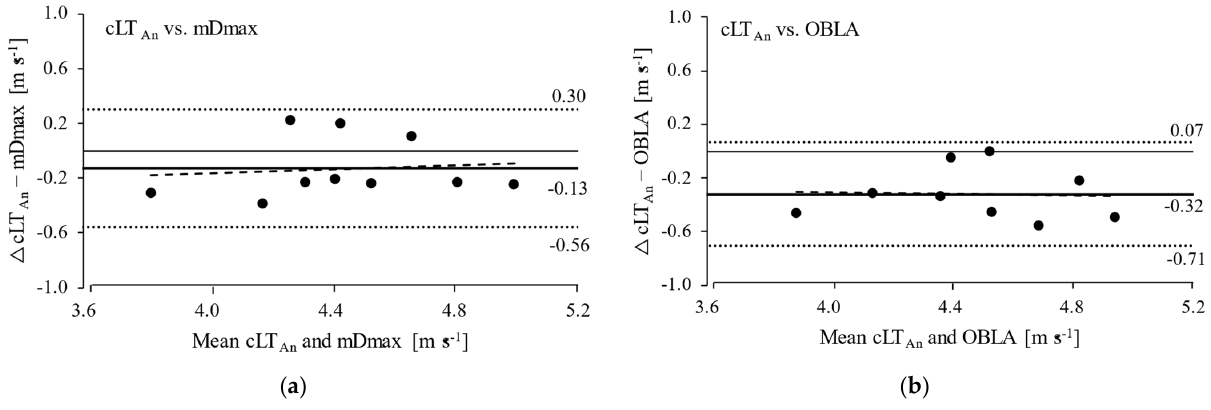
Figure 3. Bland–Altman Plots: differences in running velocity at calculated anaerobic lactate threshold (cLT An ) vs. modified maximal deviation method (mDmax; ( a )) and onset of blood lactate accumulation (OBLA; ( b )). The solid lines indicate the mean difference; the dotted lines indicate the limits of agreement (mean ± 1.96 SD); the dashed lines represent the fitted linear regression.